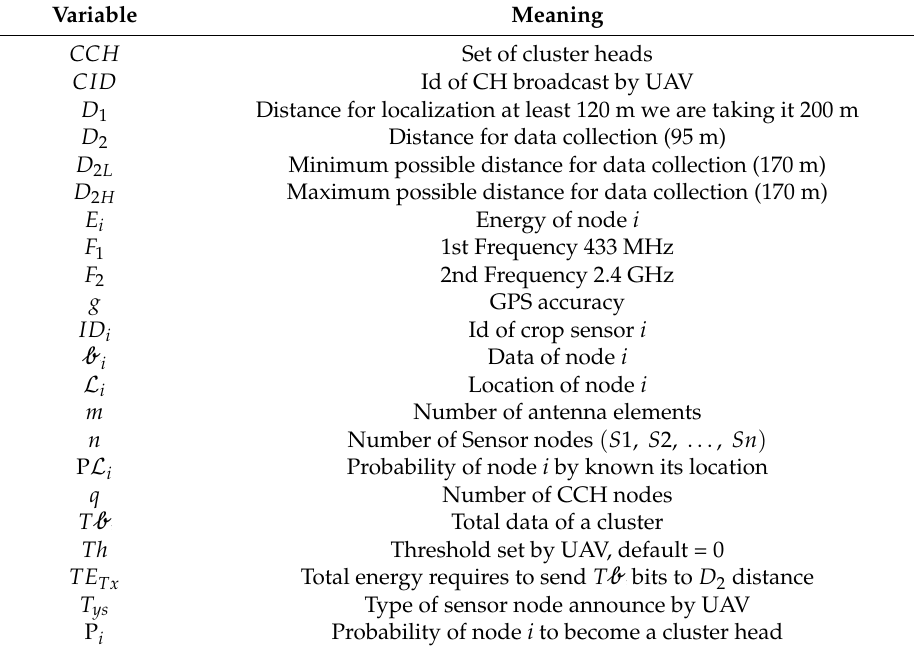
Table 4. The list of variables used in state